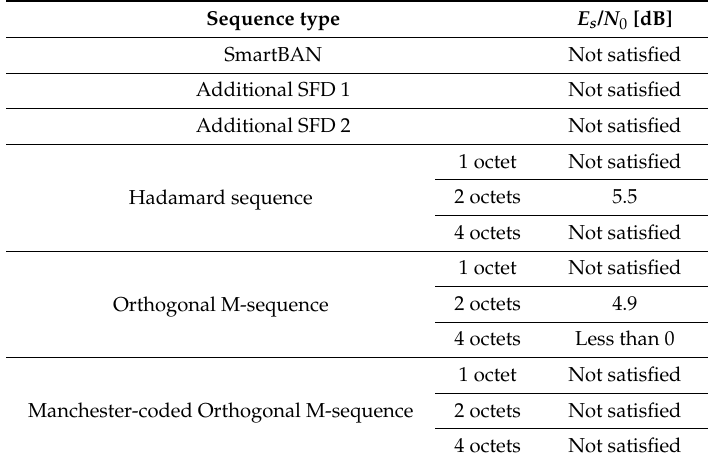
Table 7. E s / N 0 when failure detection ratio satisfies 10 − 2 or less under IEEE model CM3.